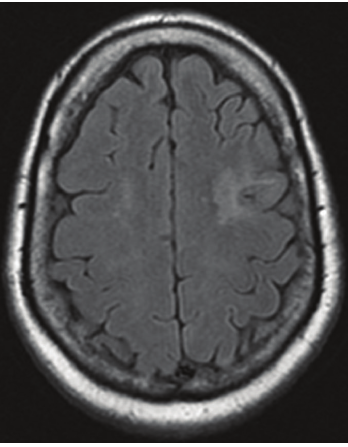
Figure 1: MRI Brain-axial T2 FLAIR showing left frontal lesion.